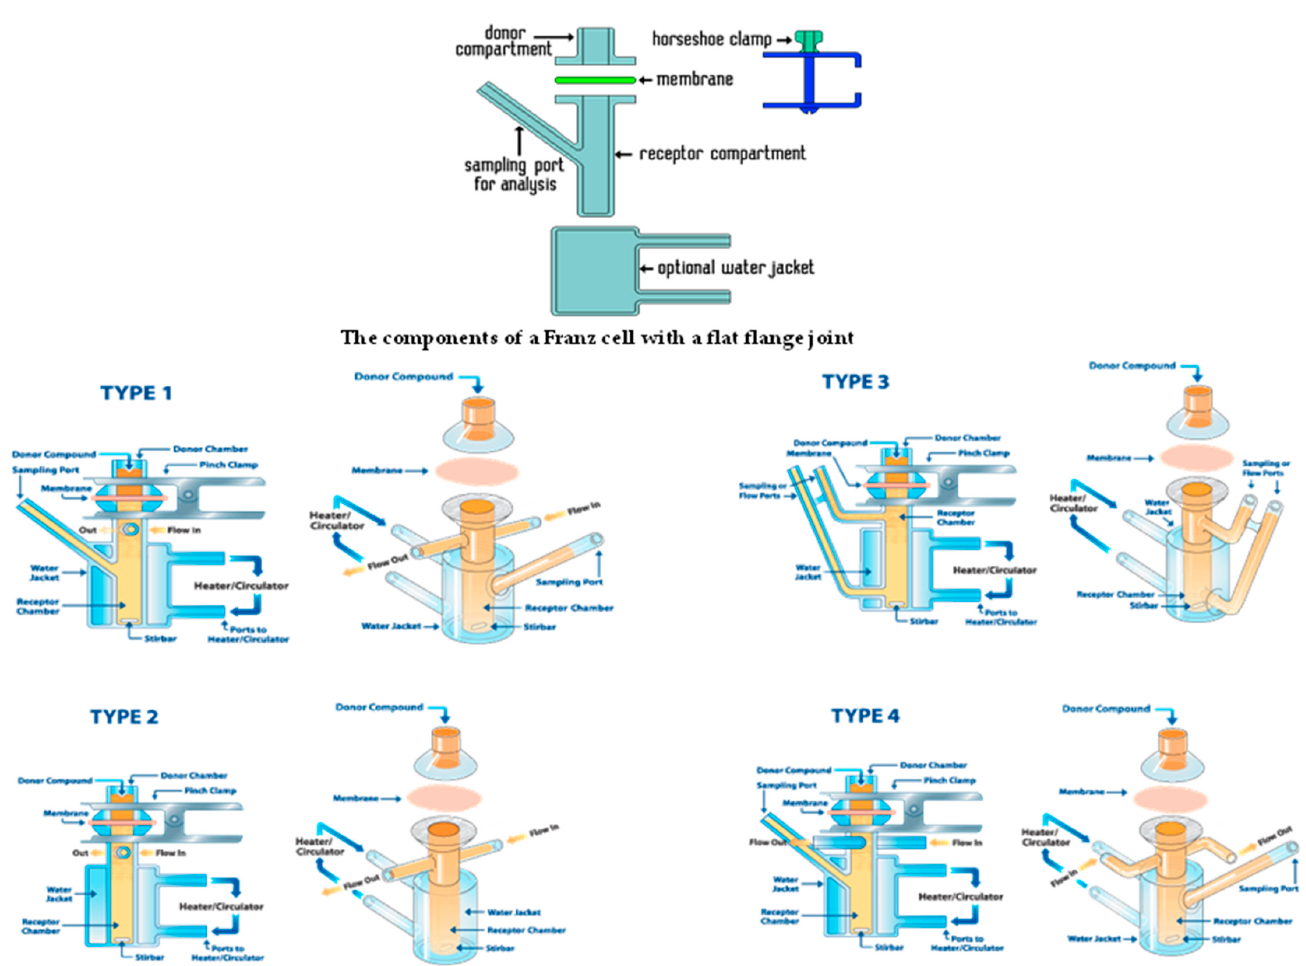
Figure 5. Illustration of the different types of diffusion cells used in the determination of transdermal flux. Images reproduced with permission from PermeGear, Inc.